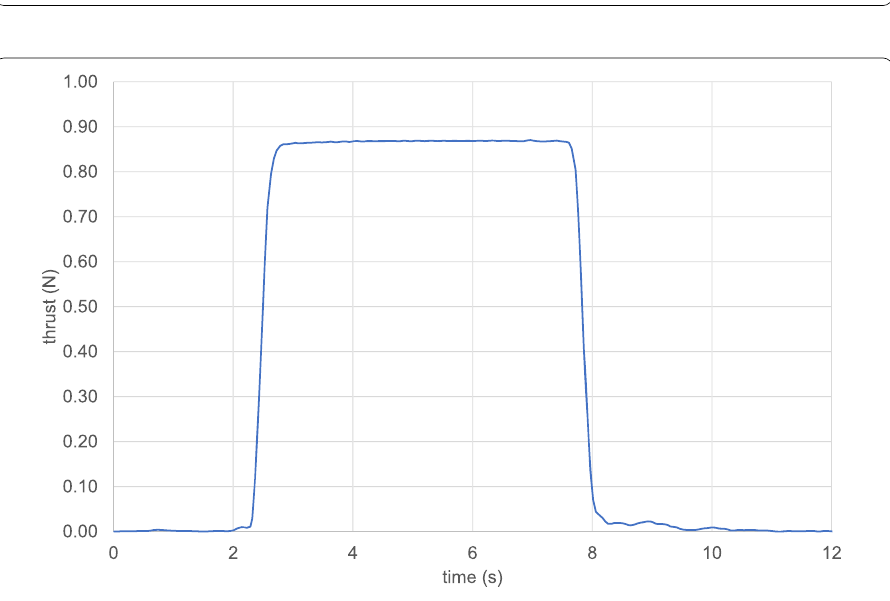
Figure 14 Force actuator made of a relay with a